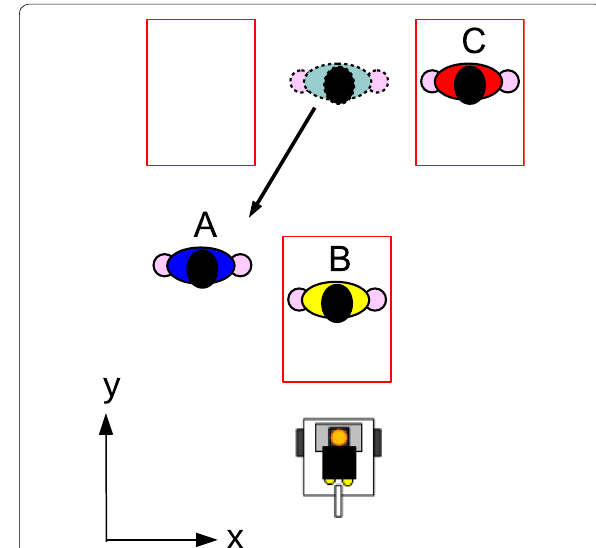
Fig. 10 An example where tracking fails when a player goes behind another player